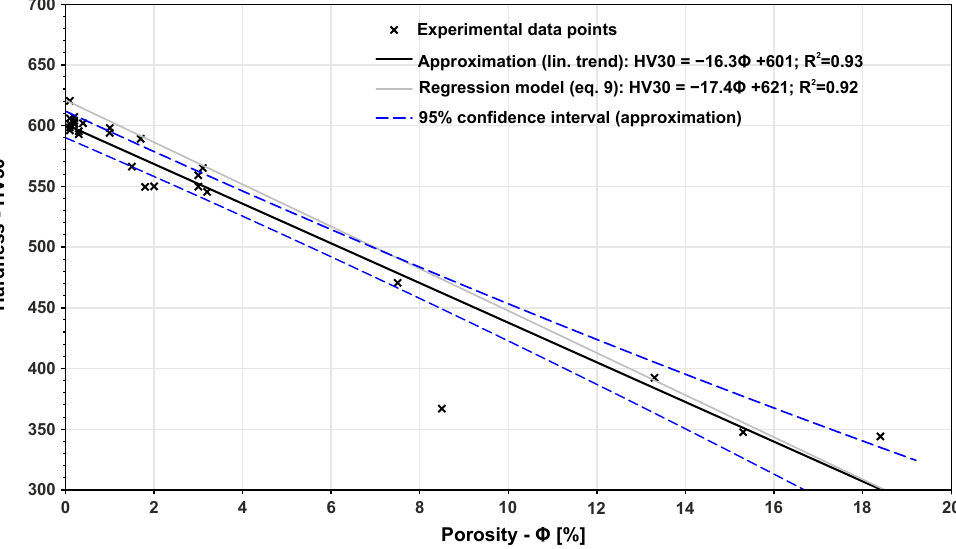
Figure 12. Mathematical relation between HV30 hardness and